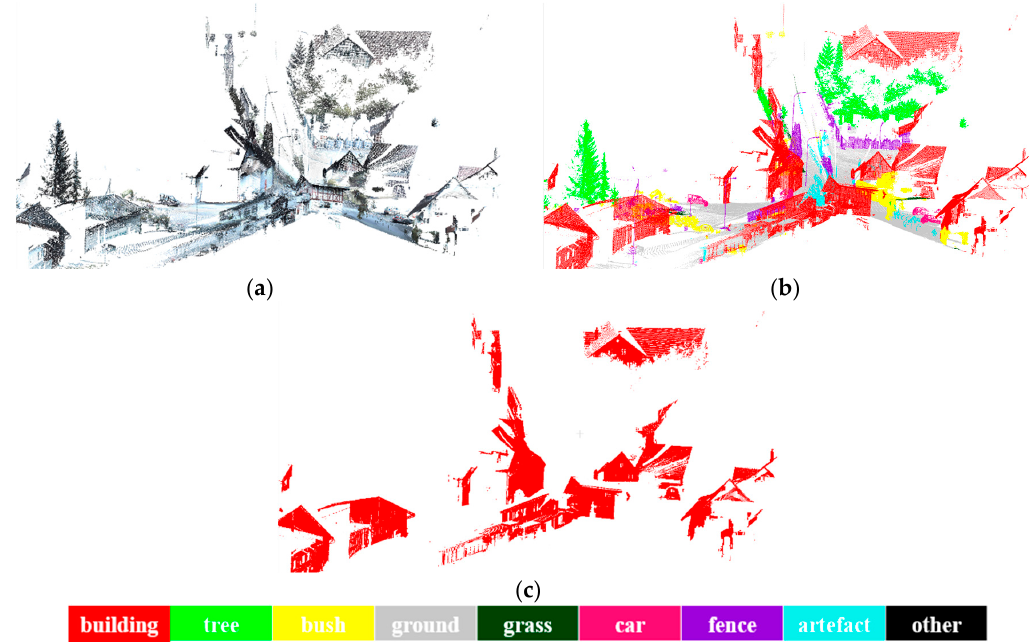
Figure 12. The results of building extraction on dataset B. ( a ) Raw data; ( b ) the final results of semantic segmentation; ( c ) the results of building extraction.